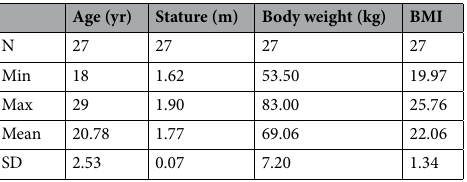
Table 1. Descriptives of the sample showing age, body size, and weight.